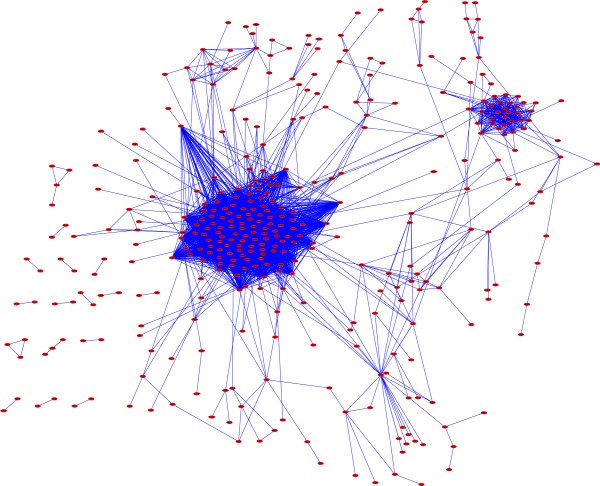
Protein-protein interaction networks of differentially expressed genes. The nodes indicate genes and the edges indicate interaction between these genes.